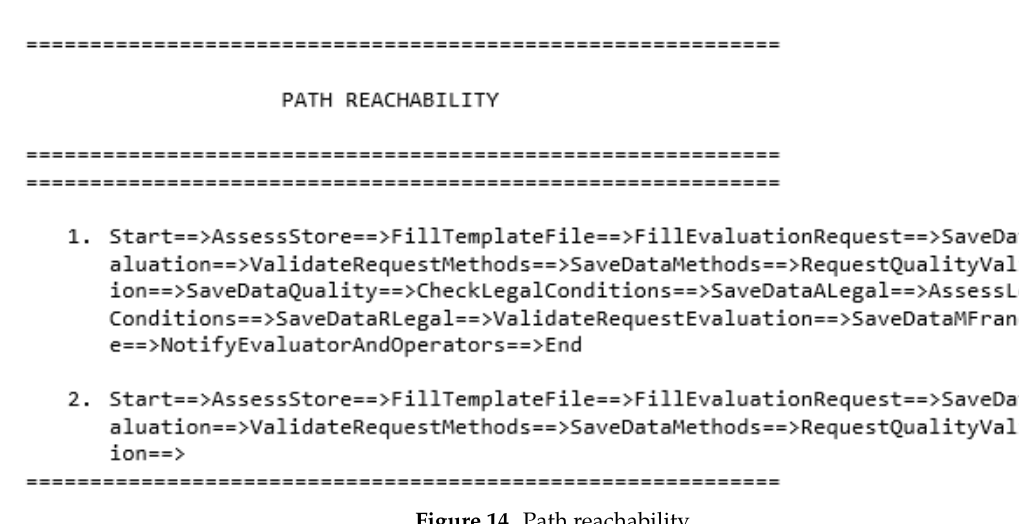
Figure 14. Path reachability. 527